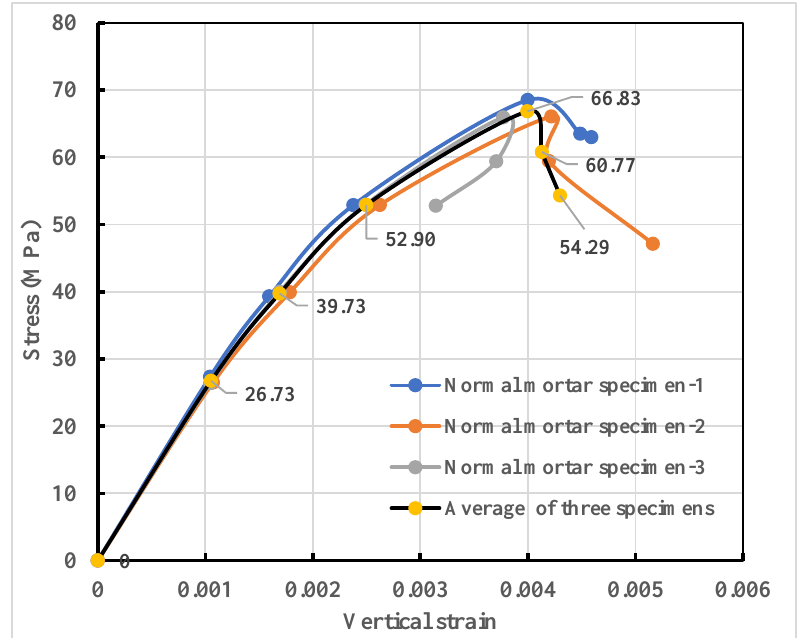
Figure 9. The uniaxial compressive stress – strain curve of the control mix. Table 4. Material properties.